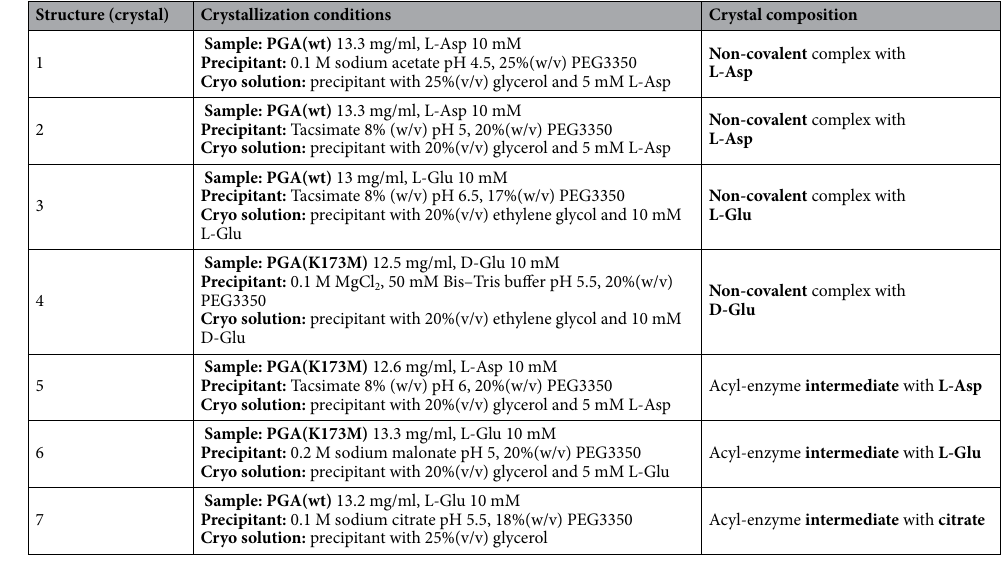
Table 1. Details of crystallization